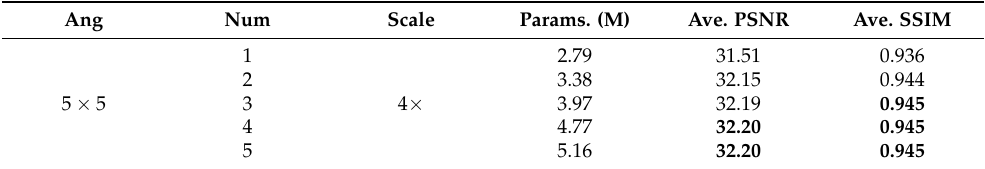
Table 5. The comparative results of different numbers of the fusion and allocation strategy for 4 × LF image SR. The best results are in bold.